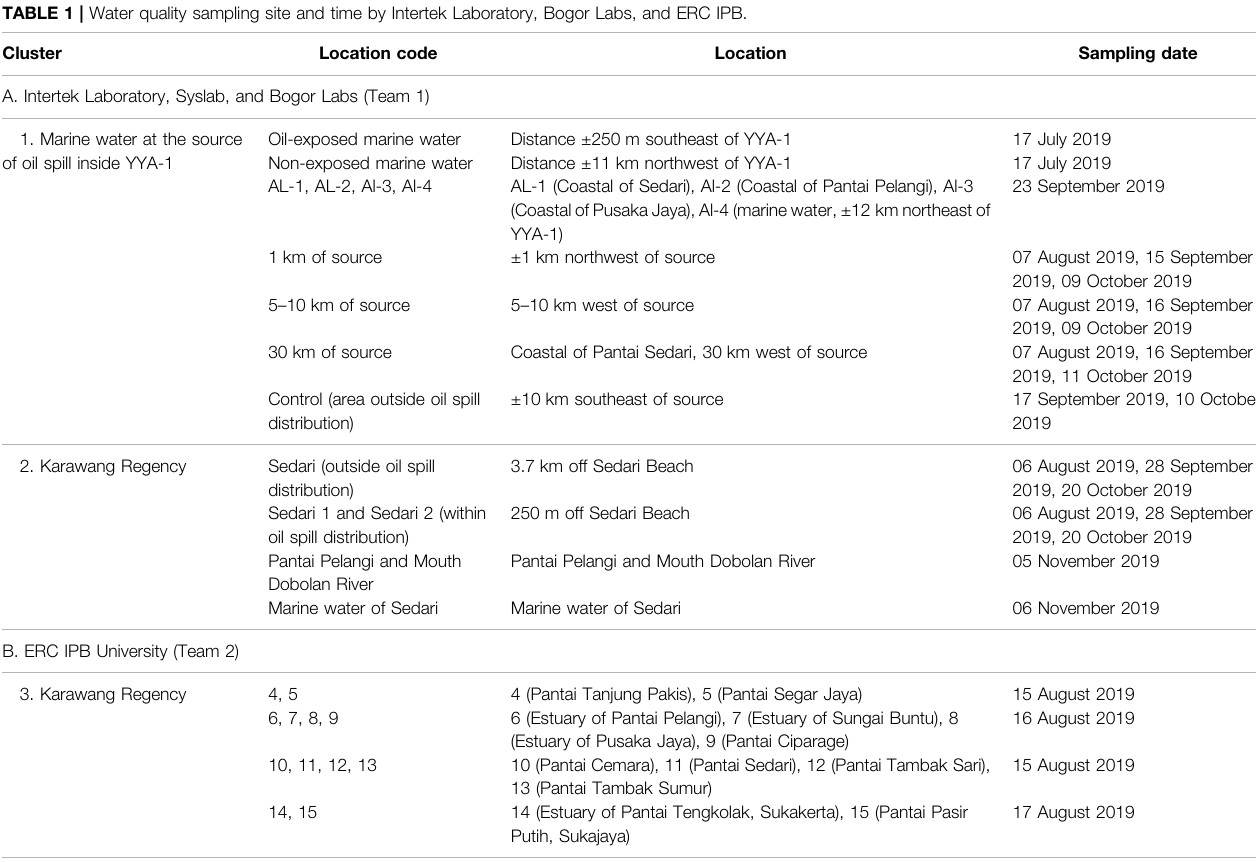
TABLE 1 | Water quality sampling site and time by Intertek Laboratory, Bogor Labs, and ERC IPB. Cluster Location code Location Sampling